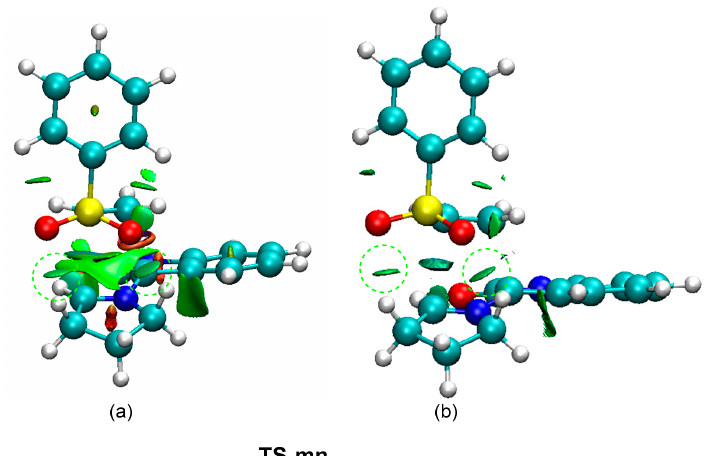
Figure 6. ( a ) NCI isosurfaces associated with the density overlap at TS-mn from − 0.08 < sign( λ 2 ) ρ (r) < 0.08 a.u, and ( b ) attractive contribution from − 0.08 < sign( λ 2 ) ρ (r) < 0.00 a.u. The attractive NCI surfaces associated with the two HBs are highlighted by a line-dashed green circle.